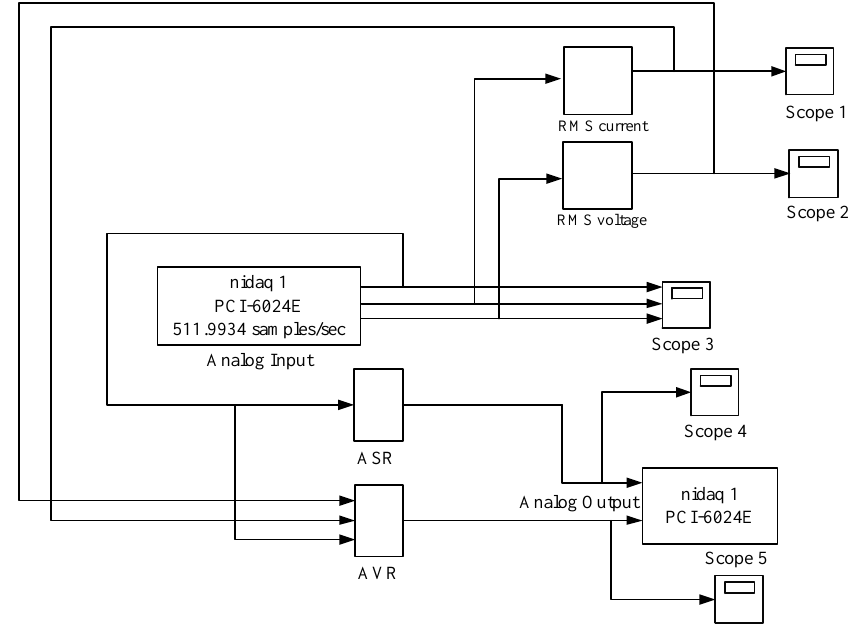
Figure 17. Simulink schematic diagram to control the DG plant physical model. The experimental data were registered using Scope units at various setpoints and ASR tuning coefficients. Based on the experimental data, a fuzzy model of rotor rotational frequency control was built and optimized. It was tested with random tuning coefficients of the regulator (Figure 18). Rotor speed, p.u.